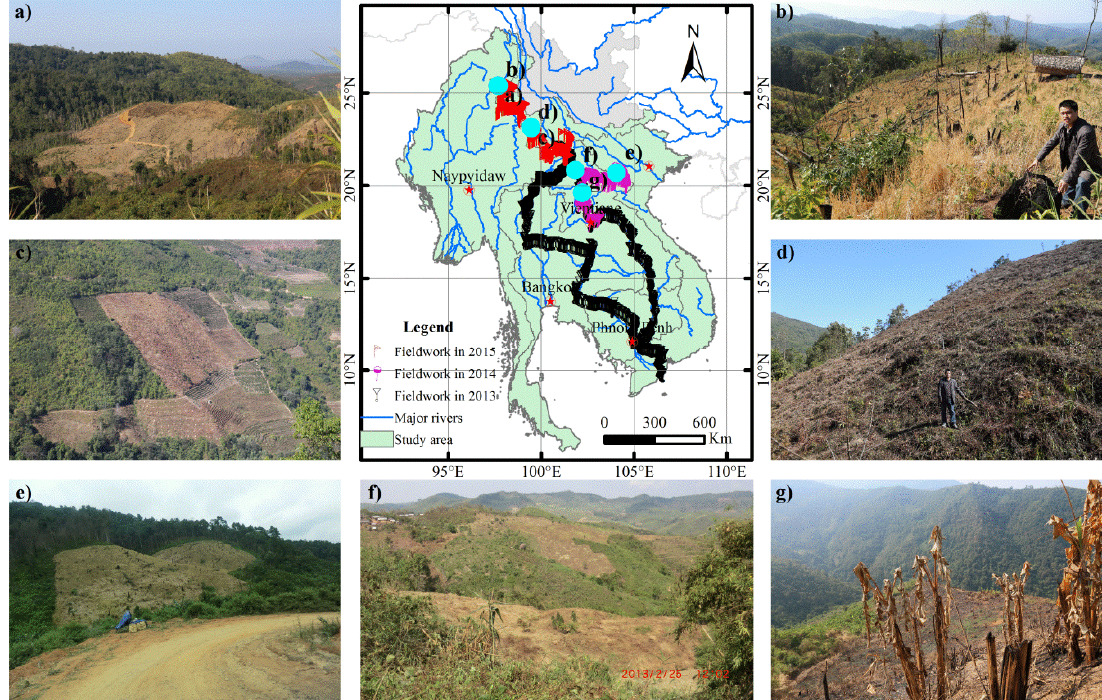
Figure 1. Location of the study area showing the fieldwork carried out in mainland Southeast Asia (MSEA) during the dry season between 2013 and 2015. Seven geo-tagged landscape photos of swidden agriculture were selected to illustrate the different development stages of swidden practice, specifically, ( a , b ) with a distance of about 5 km taken in eastern Kachin State, Myanmar, on 3 February 2015, a distance of nearly 7 km between ( c ) and ( d ) taken in Cangyuan Va Autonomous County, Lincang City, of Yunnan Province on 6 February 2015 and ( e ) in Huaphan Province on 14 November 2014; ( f ) in Oudomxay Province on 25 February 2013 and ( g ) in Luang Phrabang Province on 27 February 2013, respectively, all taken in northern Laos. Photos taken in February typically show the sun/air drying stage of swidden agriculture, while the photo in November indicates that the swidden plot was cropped and just harvested.